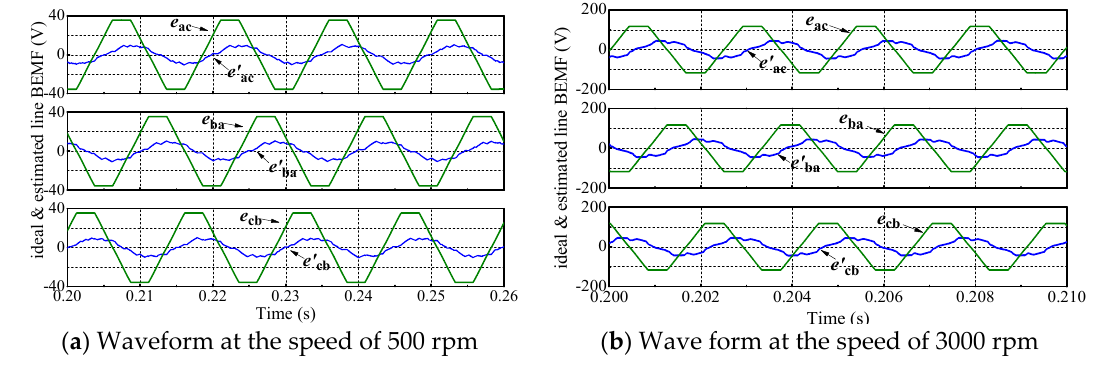
Figure 14. Ideal and estimated line BEMF.